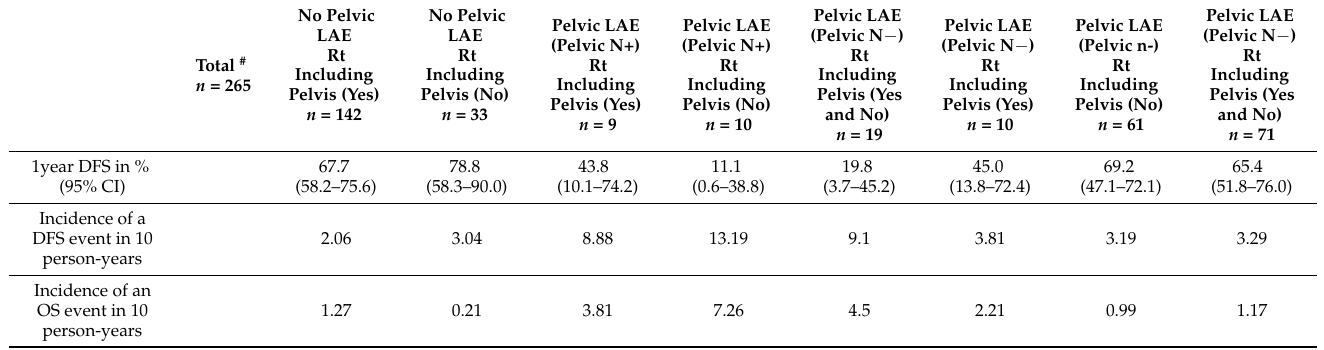
Table 8. Prognosis with regard to applied pelvic radiotherapy, pelvic nodal status, and surgical